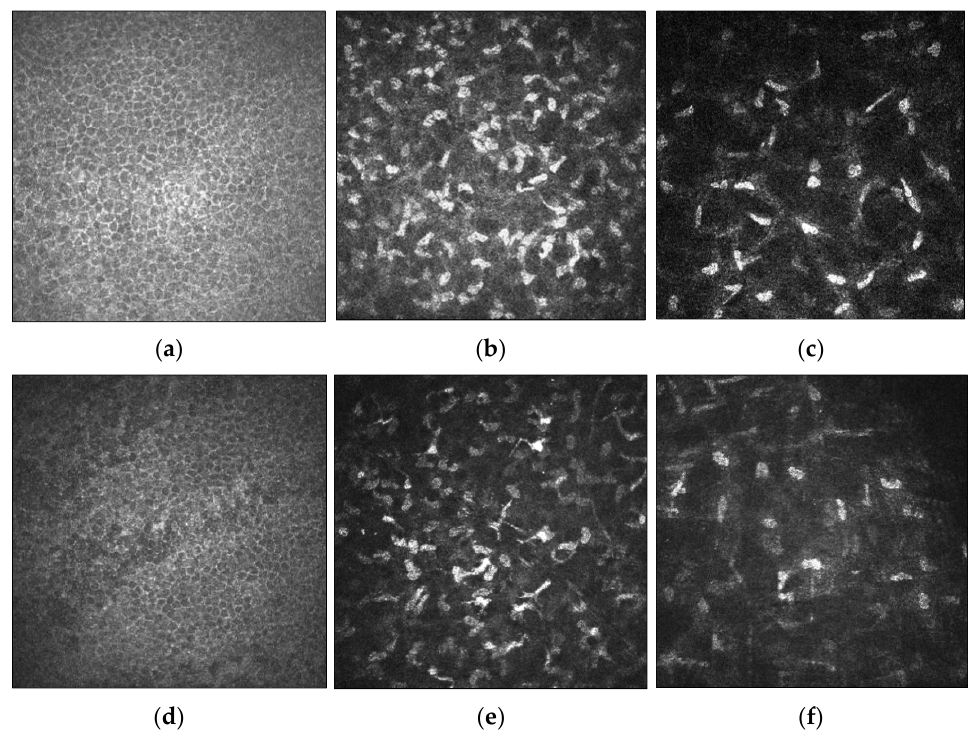
Figure 2. In-vivo confocal microscopy (IVCM) imaging of the corneal epithelium, anterior stromal keratocytes and posterior stromal keratocytes in healthy ( a – c , respectively) and keratoconic eyes ( d – f , respectively). Cell densities of the corneal epithelium, anterior stromal keratocytes and posterior stromal keratocytes are reduced in keratoconic eyes relative to healthy subjects. Scale bar: 100 µm.